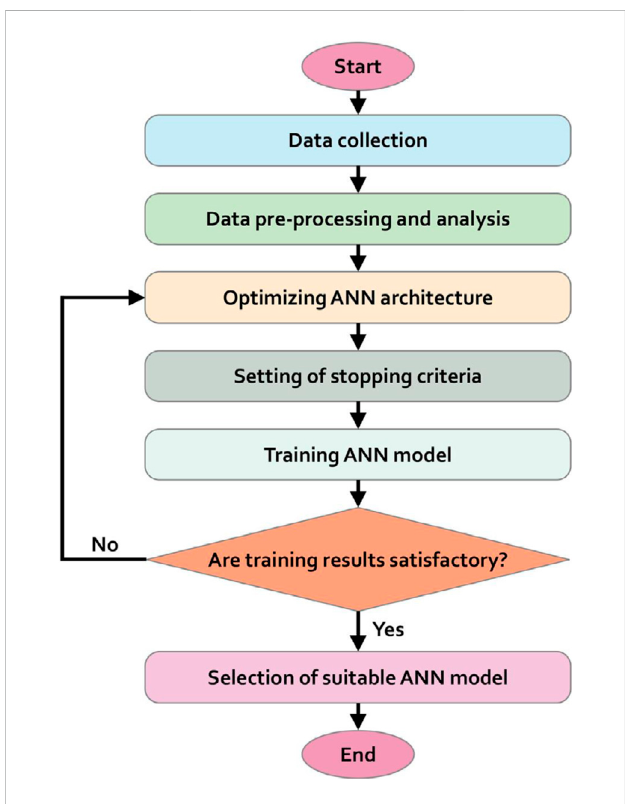
FIGURE 10 A typical fl owchart for ANN model (Aghbashlo et al.,